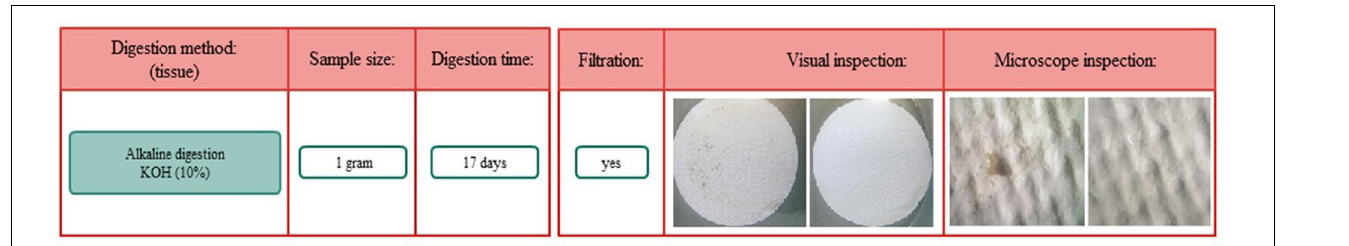
FIGURE 7 | Alkaline test results for tissue